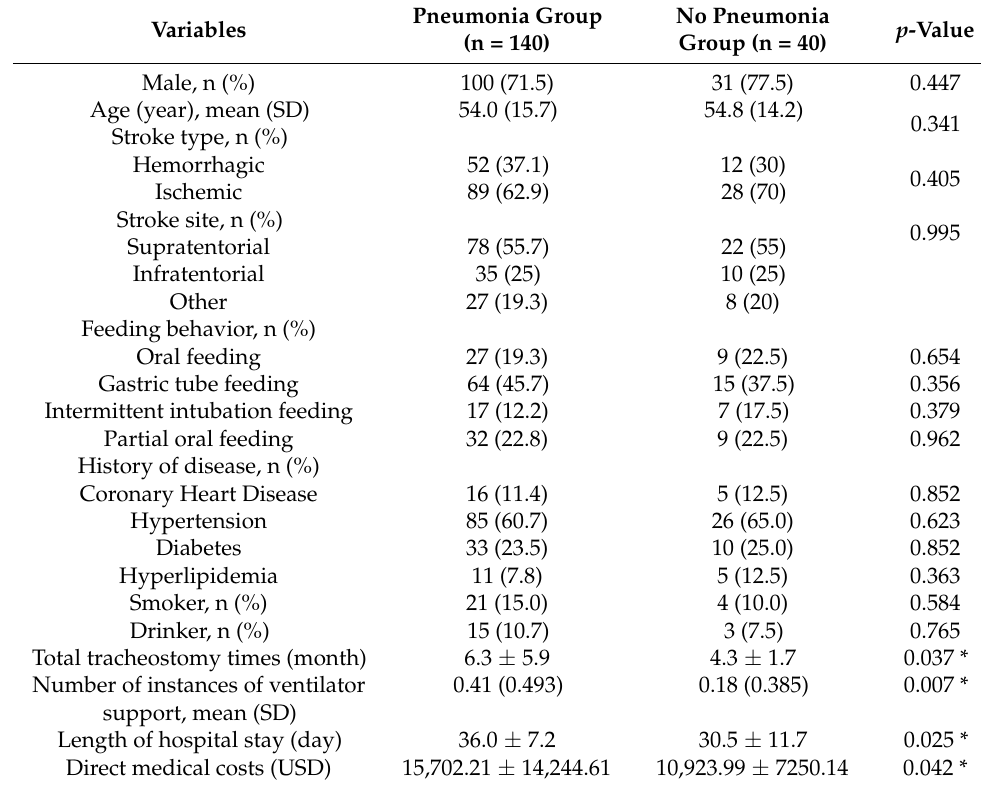
Figure 1. The flow chart of the study design. Table 2. Clinical characters of tracheostomy patients with dysphagia after